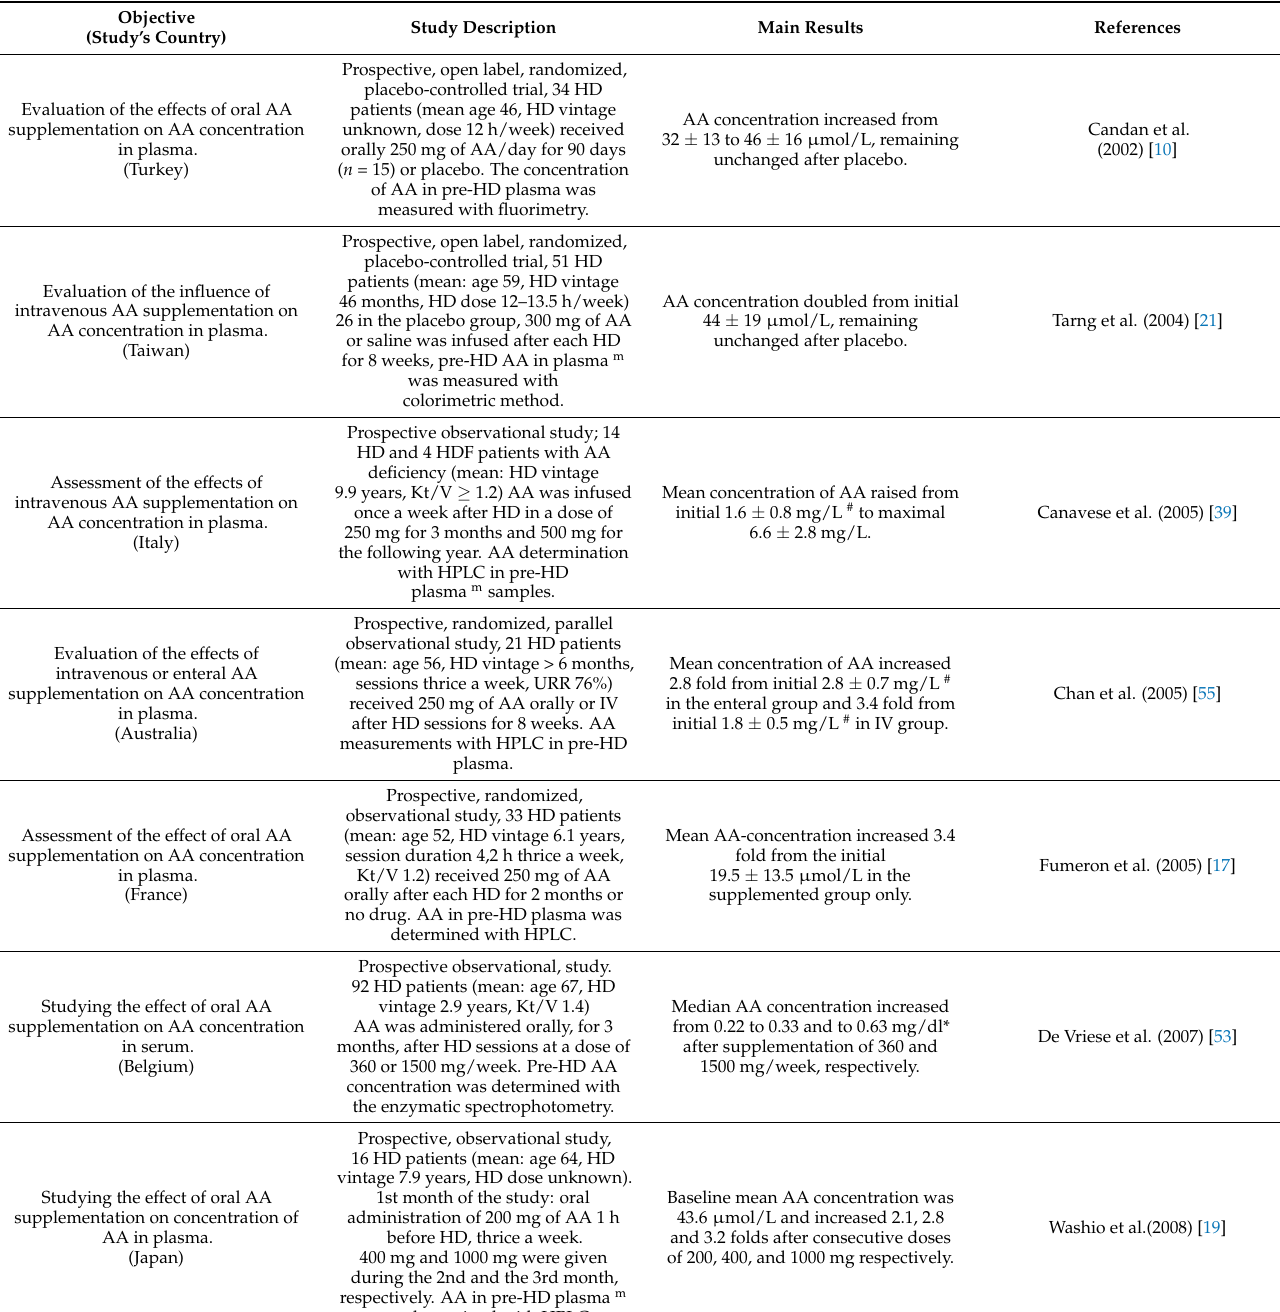
Table 2. Influence of ascorbic acid supplementation on its concentration in serum and plasma of hemodialysis